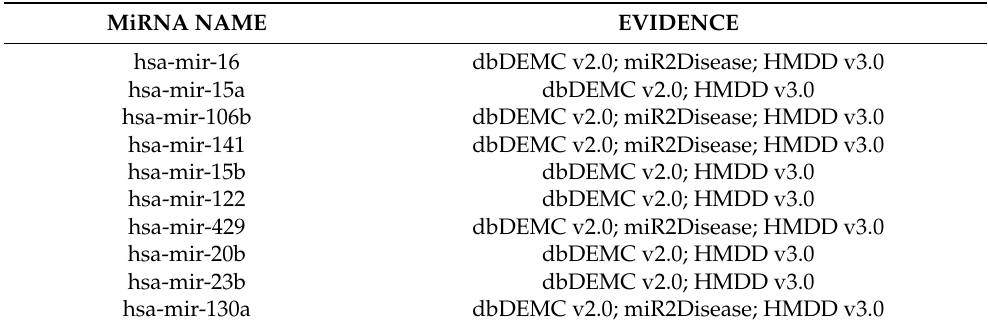
Table 9. Top 10 predicted miRNAs associated with lung